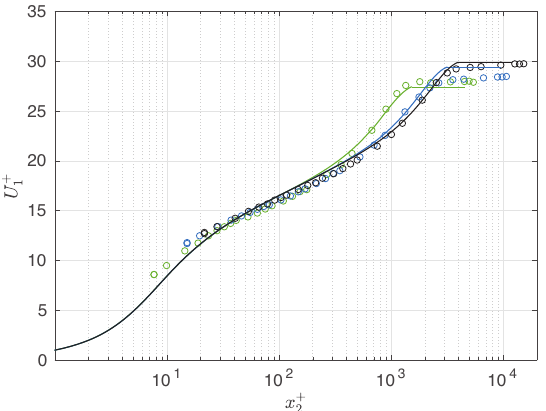
Figure 4. Mean velocity pro fi les under adverse pressure gradi- ent conditions: comparison between experimental data from Prigent, Salze, and Bailly [29] (circles) and model (solid line) at Re + = 1.5 (cid:3) 10 3 and b P = 4.3 (green), Re + = 3.2 (cid:3) 10 3 and b + = 4.0 (cid:3) 10 3 and b P = 4.5 (blue), and Re P = 4.3